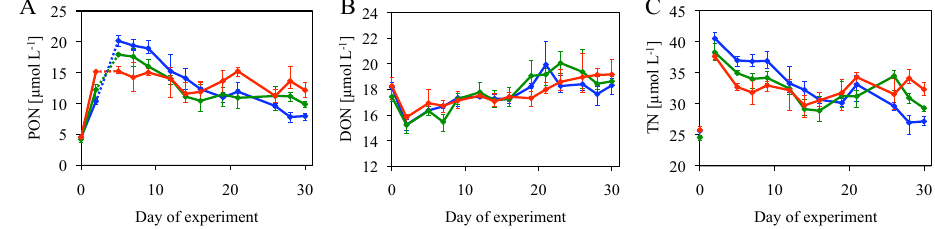
Fig. 2. Temporal development of (A) PON, (B) DON and (C) total nitrogen. Style and color-coding follow that of Fig. 1.